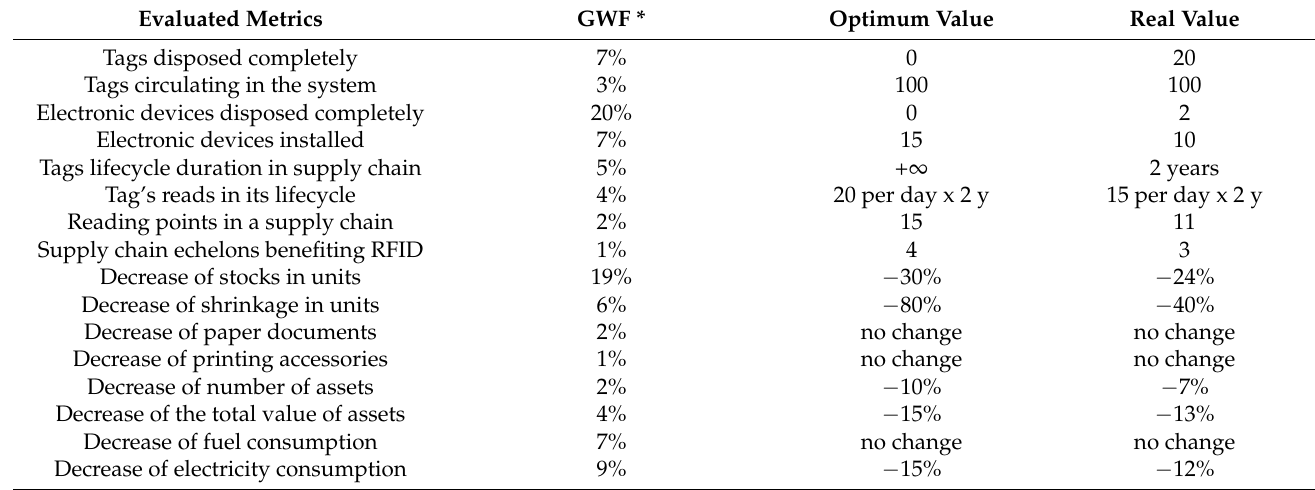
Table 5. Setting optimum and real values for the considered case.